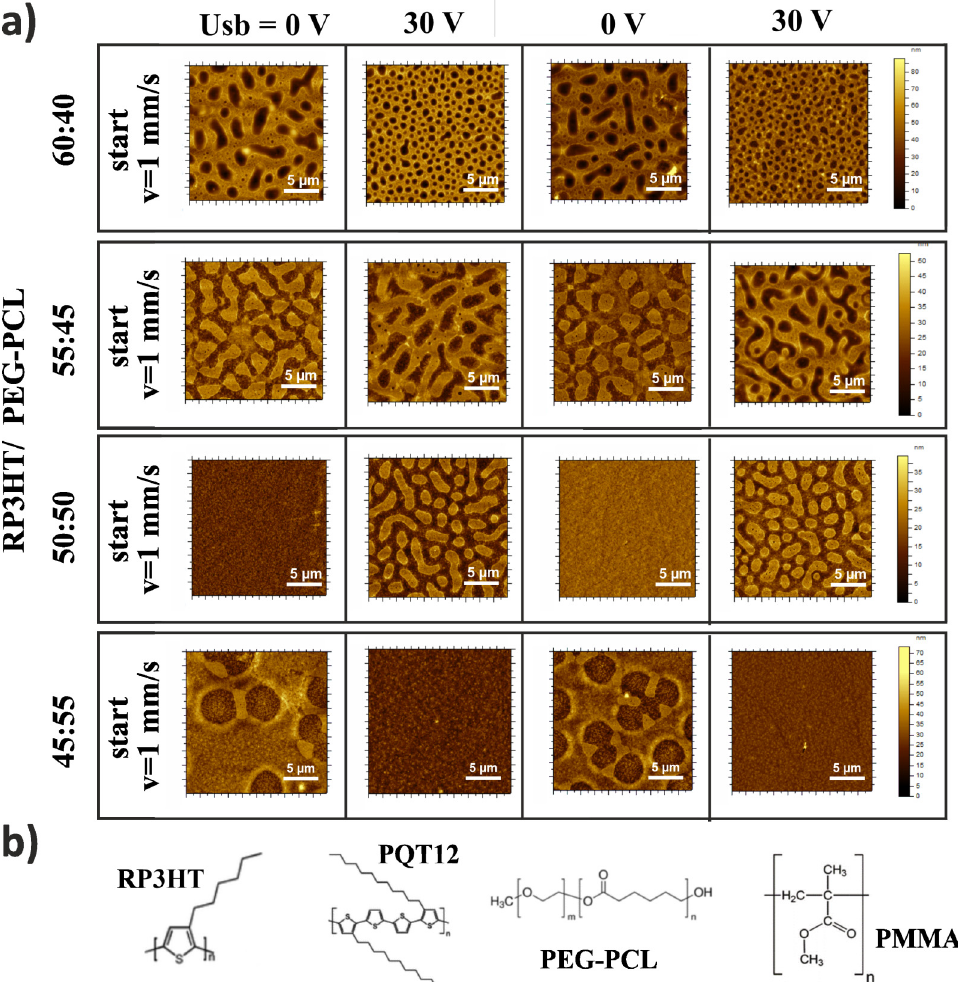
Figure 2. Reversible and repeatable electrically switched changes between different morphologies along the cast film. ( a ) AFM height images of RP3HT/PEG-PCL composites dissolved with different weight ratios (rows) in chlorobenzene and H-dip-coated with a pulsed E-field provided by a 30 V voltage Usb ( t ) periodically switched on and off (columns). ( b ) Chemical structures of the semiconductors, RP3HT and PQT12, and insulators, PEG-PCL and PMMA, that form the bicomponent polymer composites examined in this study, all dissolved in chlorobenzene at a fixed total polymer concentration of 1.33 wt%.